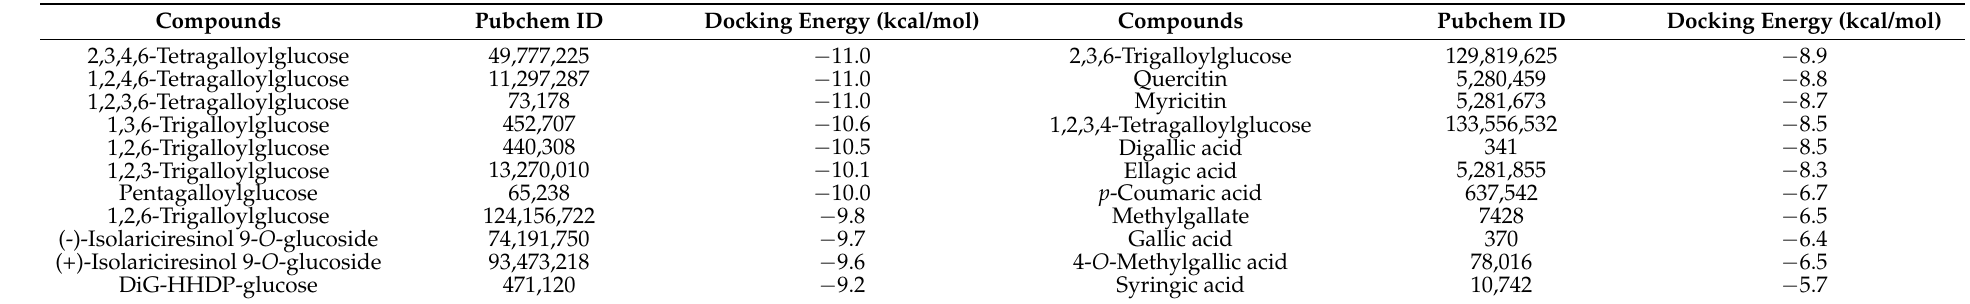
Table 2. The virtual screening results of mainly identified phenolic compounds from water caltrop ( Trapa quadrispinosa Roxb.) husk.